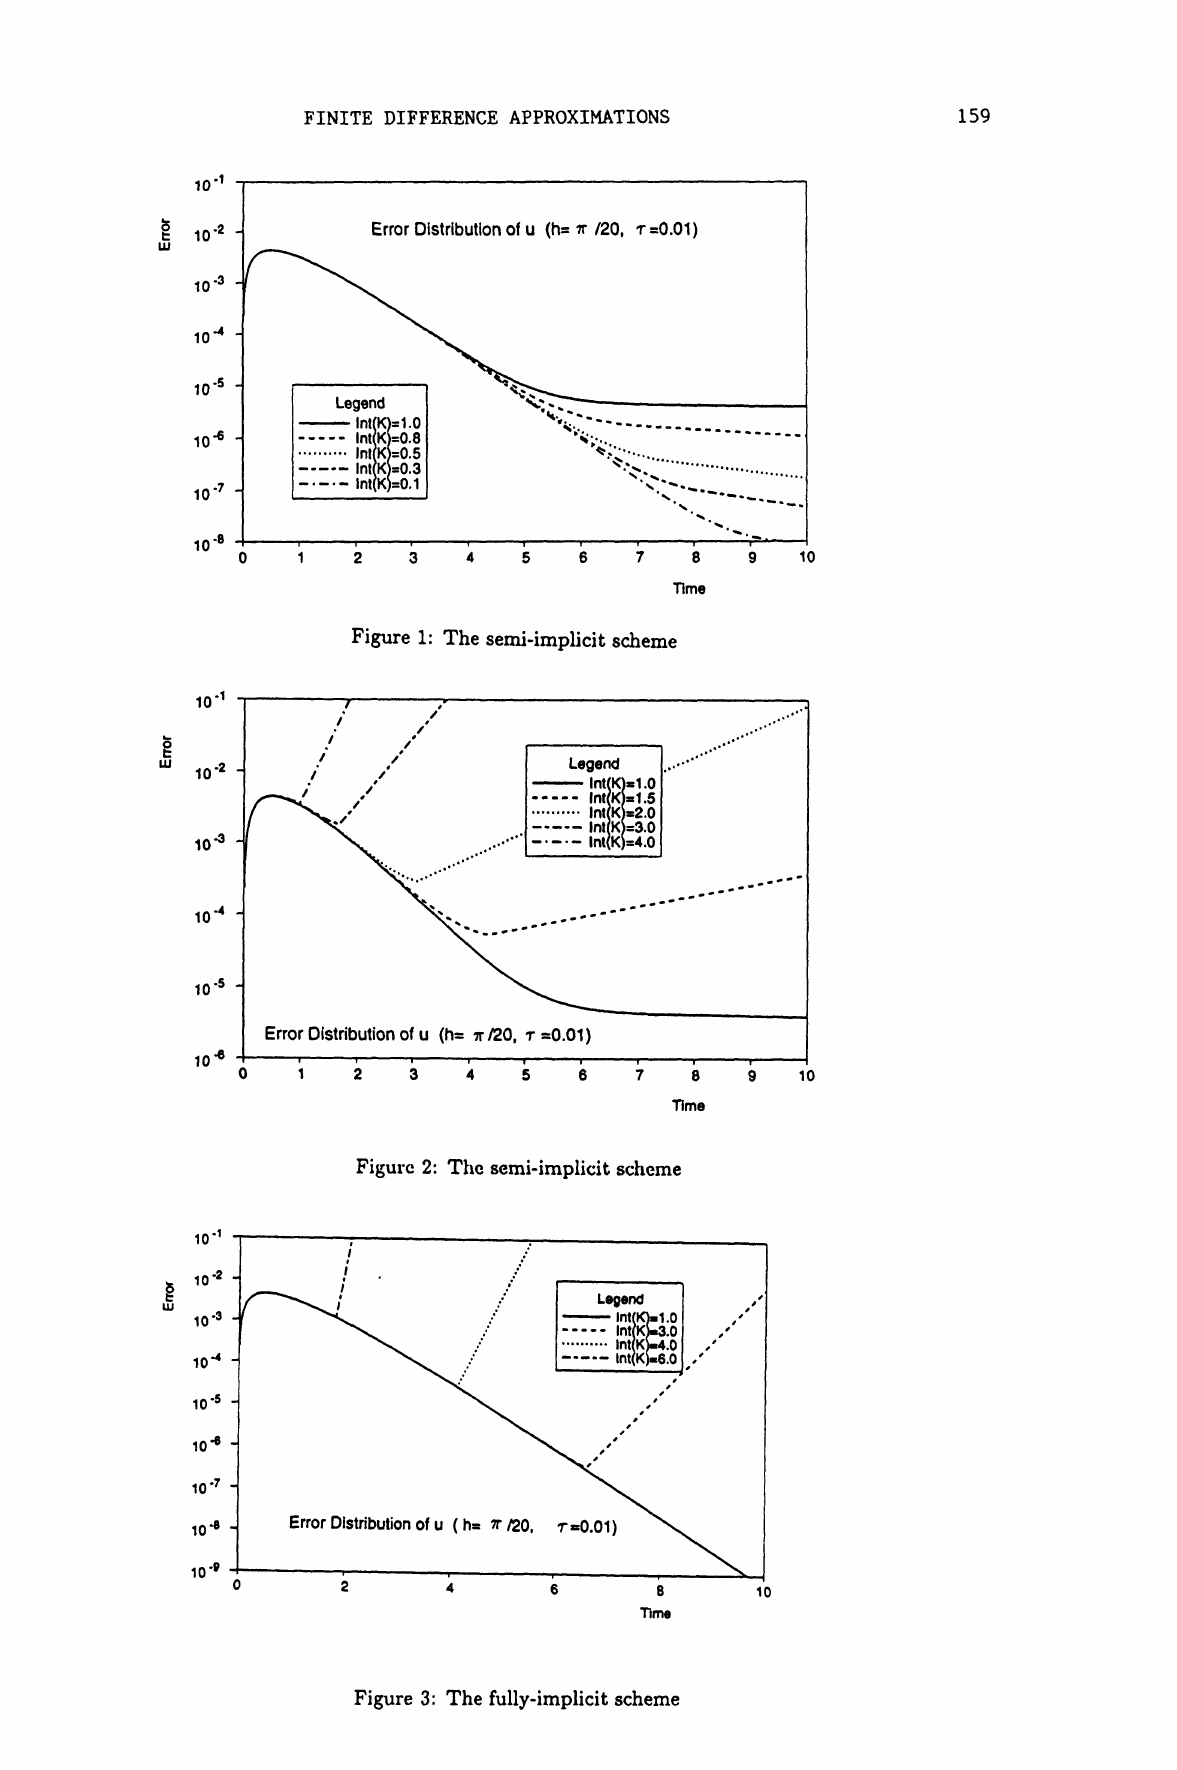
Figure 2: The semi-implicit scheme